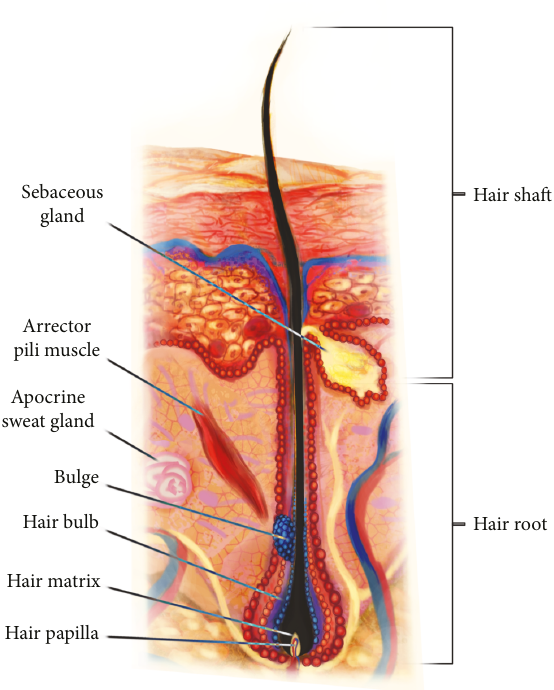
Figure 1: Hair follicle